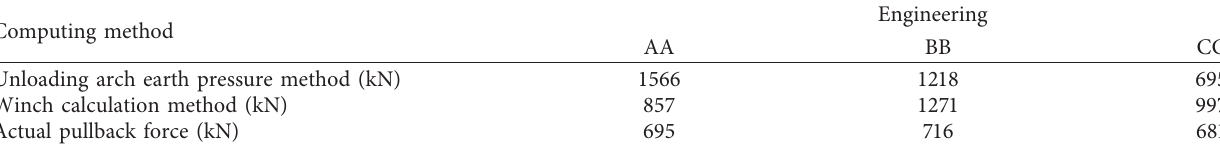
Table 2: Table of calculation results after improvement.